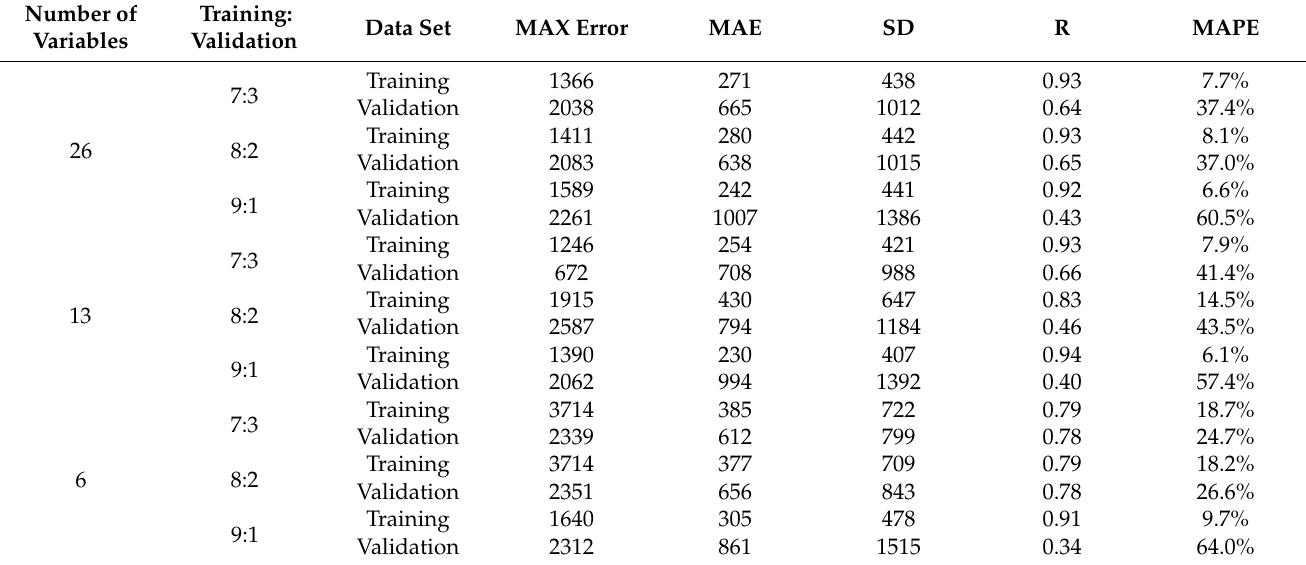
Table A15. Analysis of the results of the CHAID model for natural gas consumption.